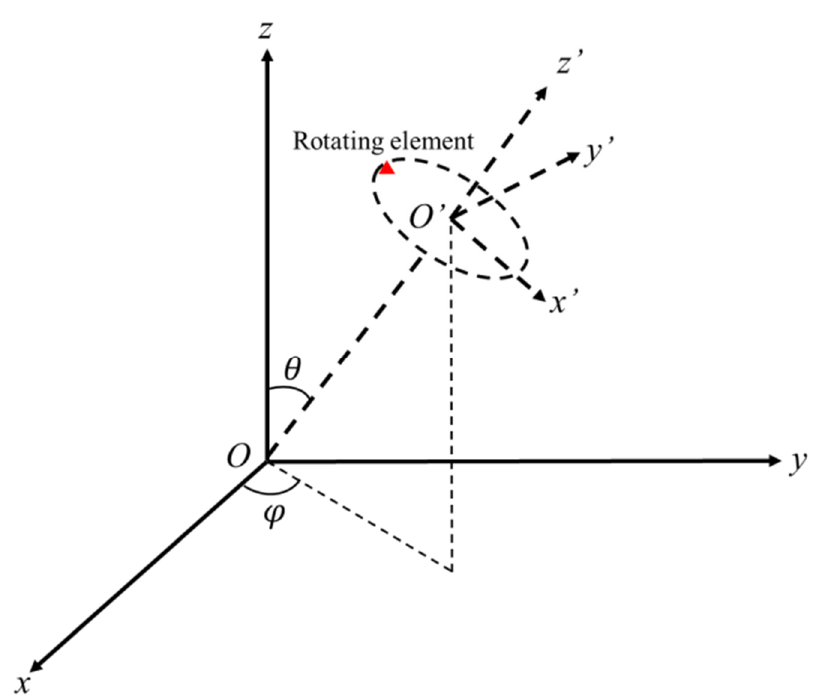
Figure 2. Schematic diagram of rotating element and rotation axis.